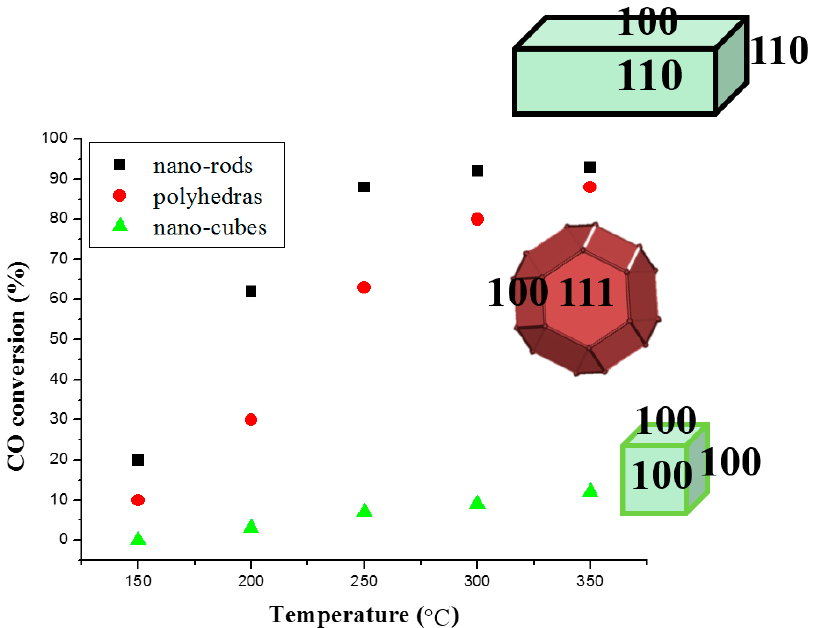
Figure 3. Gold nanocluster for the water gas shift (WGS) reaction: Different morphologies of the obtained gold nanoclusters and their Catalytic activity during the WGS reaction. Adapted from Si et al. [138].